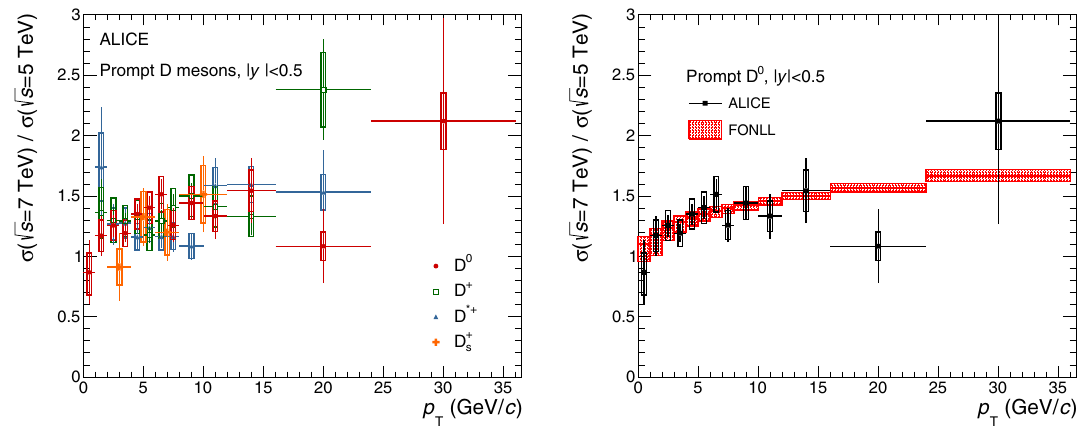
√ √ s = 7 TeV [27] and s = 5 . 02 TeV as a function